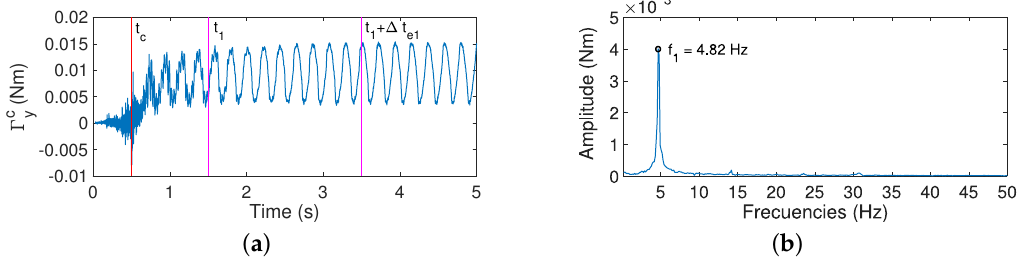
Figure 13. ( a ) Coupling torque Γ c y ; ( b ) magnitude of the fast Fourier transform of Γ c y after the impact.